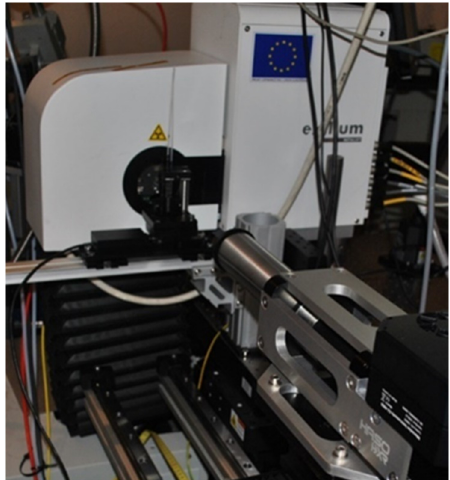
Figure 15. Experimental setup for phase imaging showing the Excillum X-ray source, the sample and the hard X-ray wavefront sensor (HASO